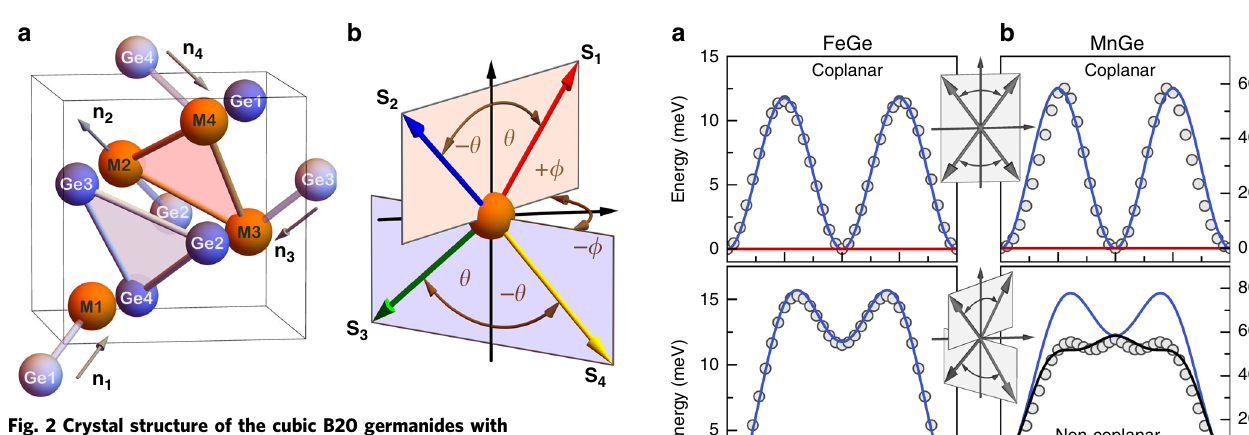
Fig. 2 Crystal structure of the cubic B20 germanides with antiferromagnetic spin texture. a The unit cell contains four magnetic (M = Fe, Mn) and four Ge (blue) atoms. The vector n i indicates the local three-fold rotation axis on the i th atom type. b The particular antiferromagnetic spin con fi guration of the magnetic moments S i used in this work is de fi ned by θ and ϕ